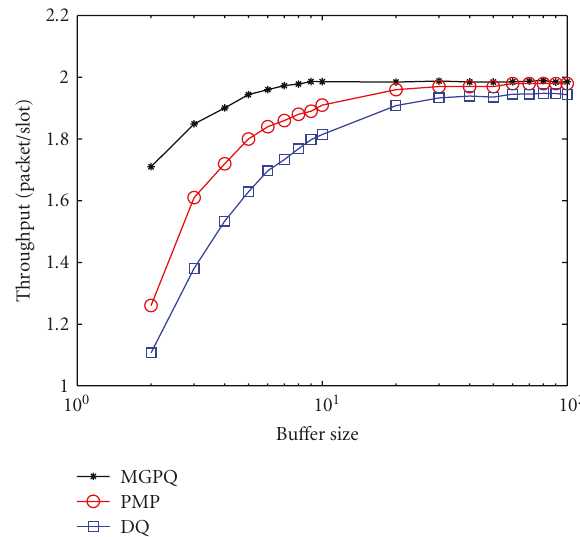
Figure 8: Throughput comparison between MGPQ, PMP, and DQ for di ff erent bu ff er sizes.